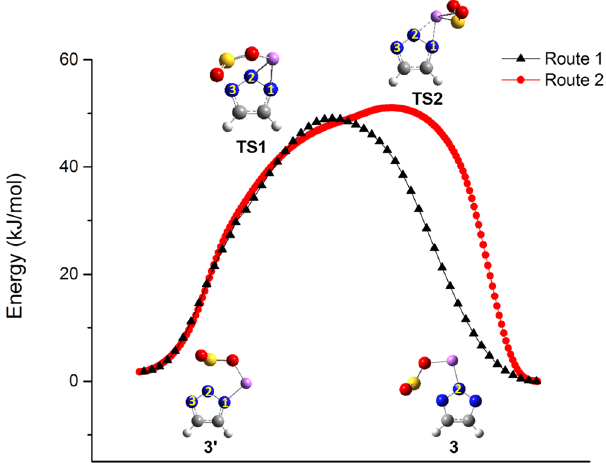
Figure 4. Two stable configurations of the 3 -Li + -SO 2 complex and their interconversion implemented by the IRC method. N1 and N3 are not labelled in 3 as the two pathways lead to products with SO 2 binding at either N1 or N3, but their structures are identical due to the same functional groups on the two C